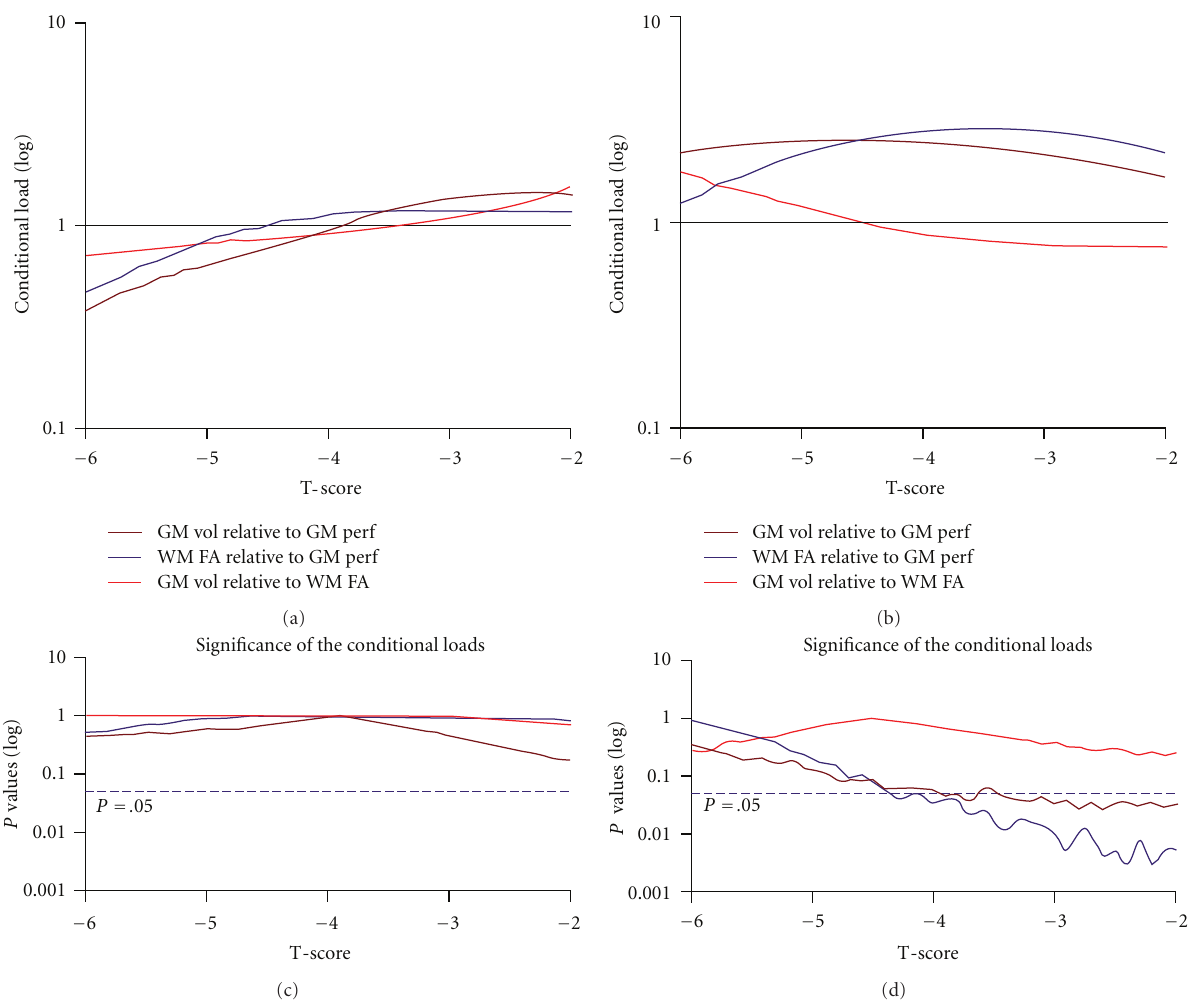
Figure 3: Conditional load of one modality relative to another as a function of the level of abnormality (T-score) for AD (a) and FTD (b). Note, vertical axes in (a) and (b) are plotted on a logarithmic scale (base-10) where a value larger than one indicates the load from a particular modality was higher than the load from reference modality. Conditional load lower than 1 indicated opposite relations between modalities. The extent to which di ff erences in the conditional loads among modalities are above chance ( P < . 05) across the level of abnormality is indicated in plot (c) for AD and in plot (d) for FTD. Note, P values in (c) and (d) are also plotted on a logarithmic scale. The horizontal dash lines indicate P = . 05